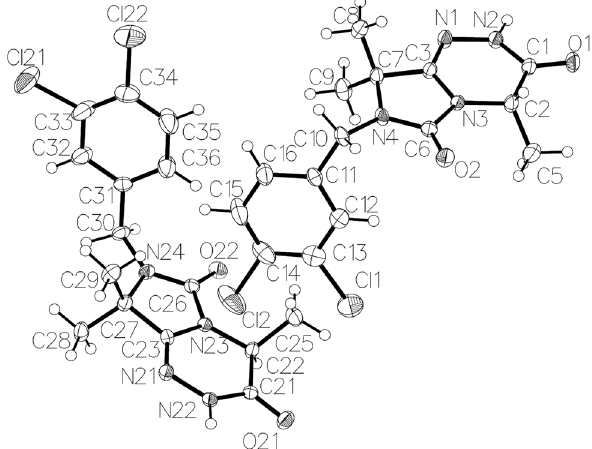
Table  : Data collection and